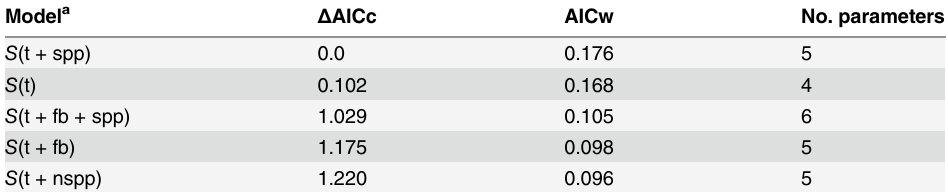
Table 3. Set of competing models (within 2 Δ AICc of top model) that include vegetative covariates in fl uencing neonatal white-tailed deer survival in the fi rst 10 days of life at Fort Bragg Military Installation, North Carolina, 2011 – 2012. Model a Δ AICc AICw S (t + spp)